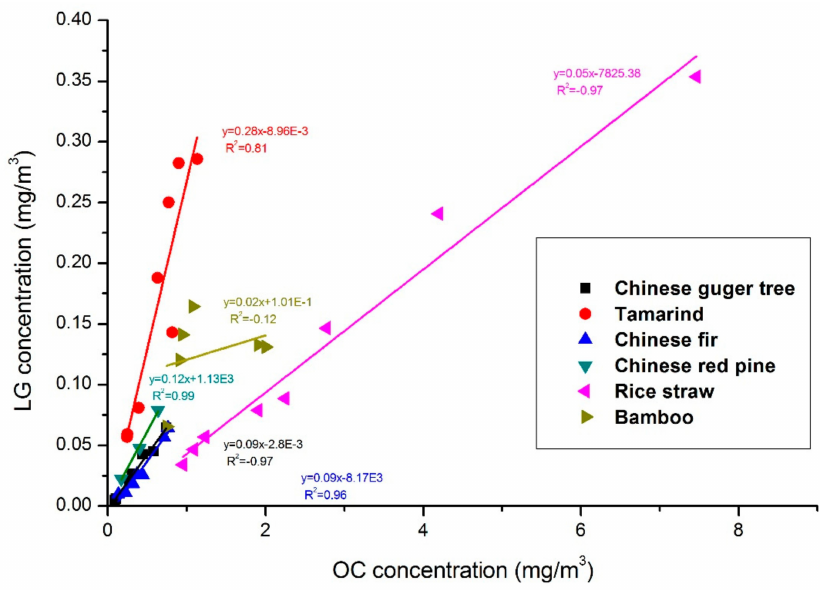
Figure 6. Correlations between LG and OC for di ff erent biofuel